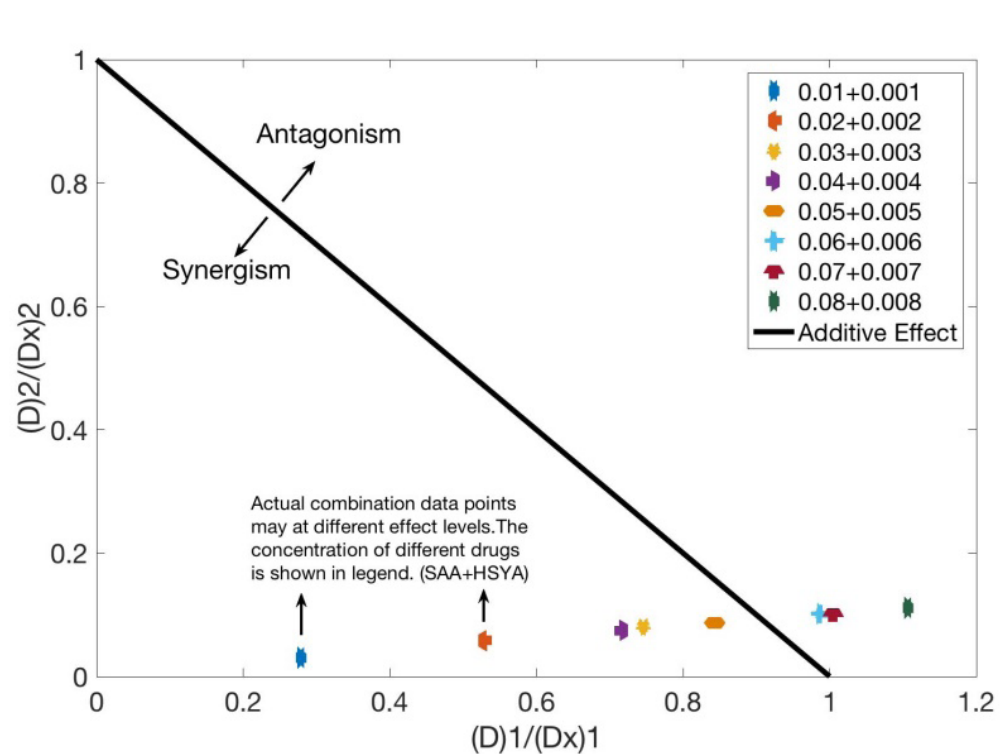
FIGURE 7 - The normalized isobologram figure when the ratio of SAA and HSYA is